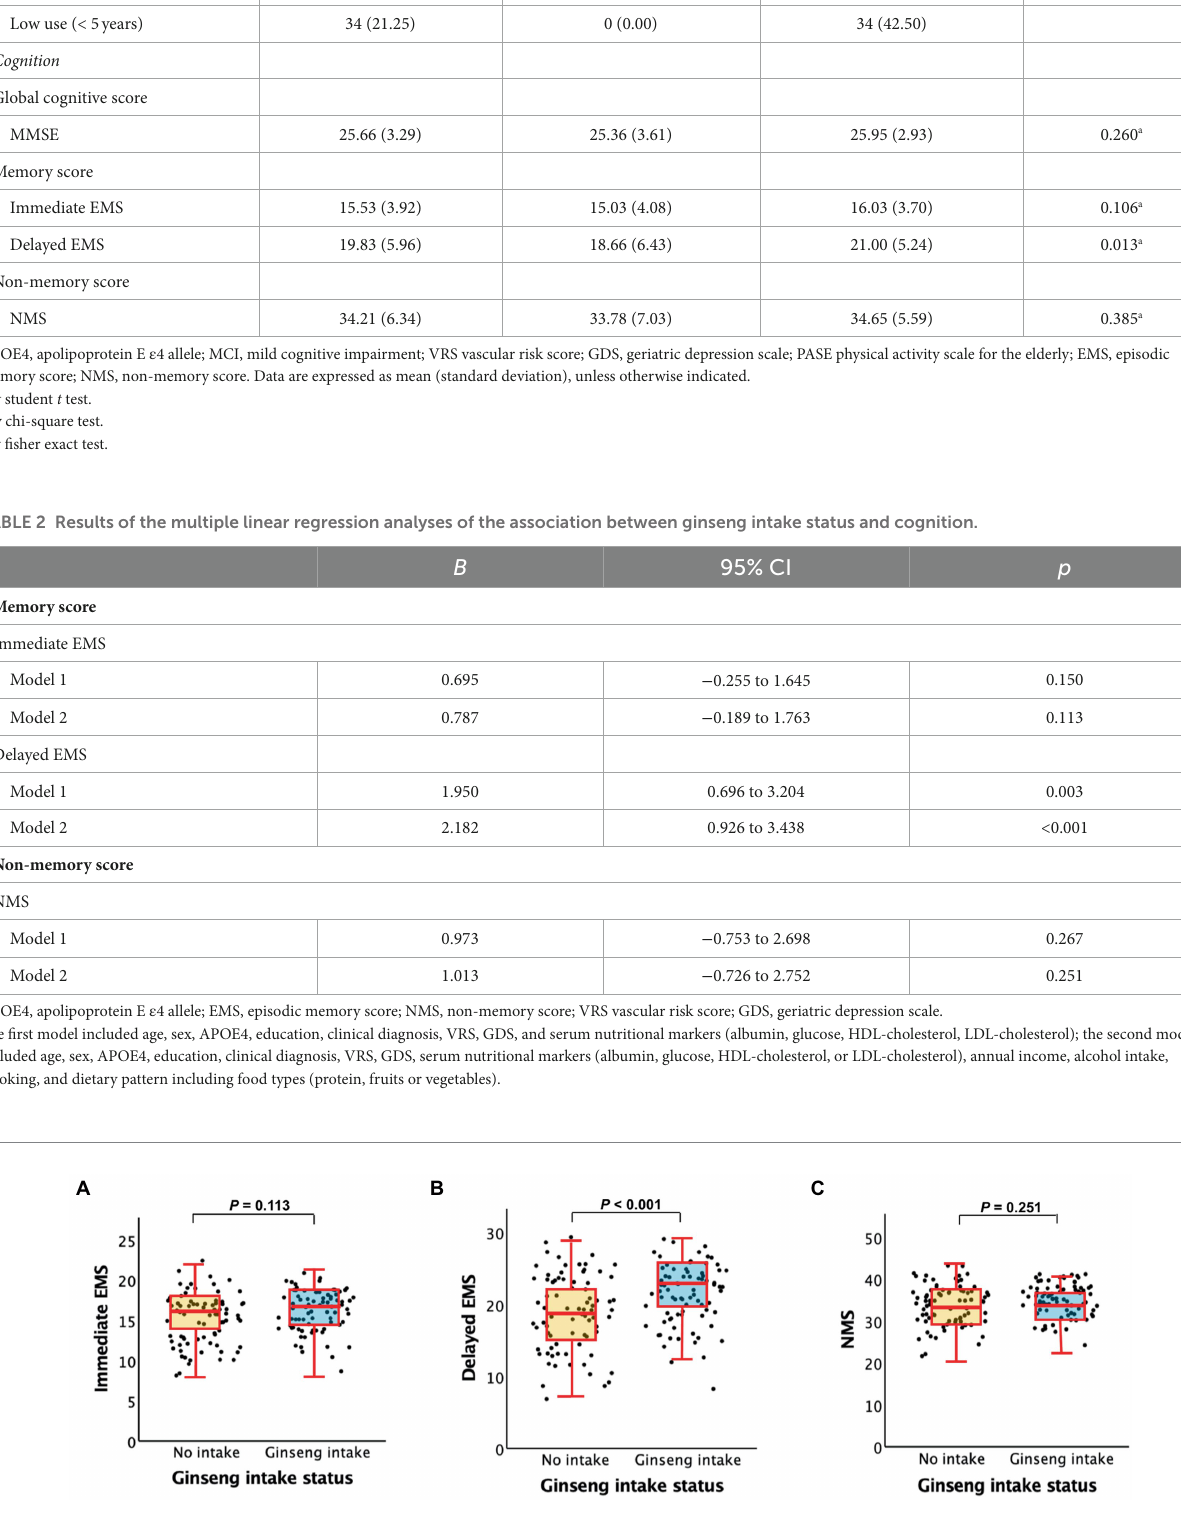
FIGURE 1 Box plots displaying ginseng intake status [(no ginseng intake vs. ginseng intake) and cognitive performances (A) . immediate EMS, (B) . delayed EMS, and (C) . NMS] in older subjects. EMS, episodic memory score; NMS , non-memory score. Multiple linear regression analyses were performed after adjusting for all potential